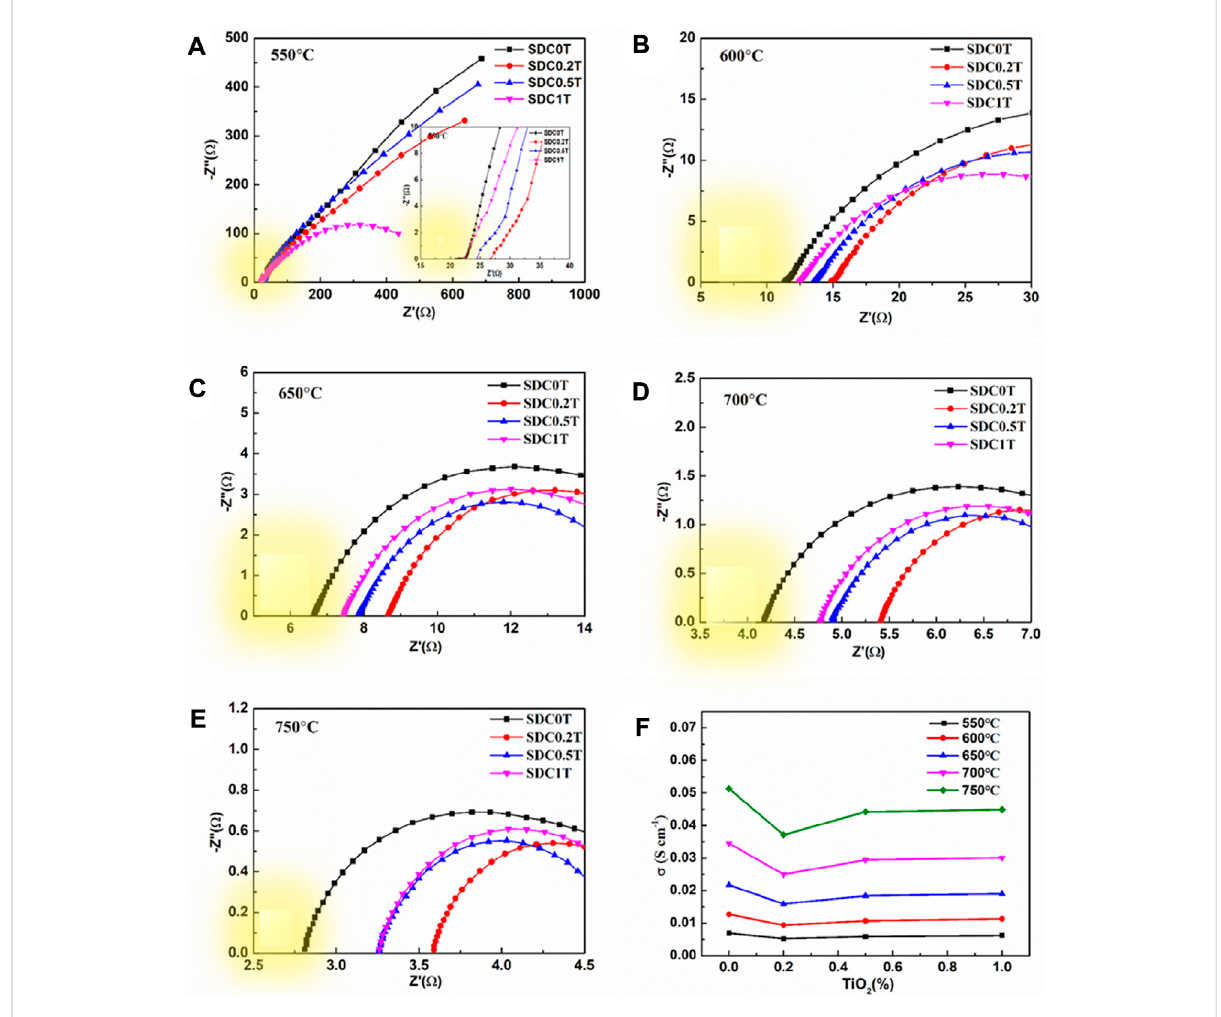
FIGURE 4 (A – E) Nyquist diagram of the impedance spectra for SDC-xT obtained at 1,400 ° C. (F) The electrical conductivity of the SDC-xT from 550 ° C to 750 ° C.